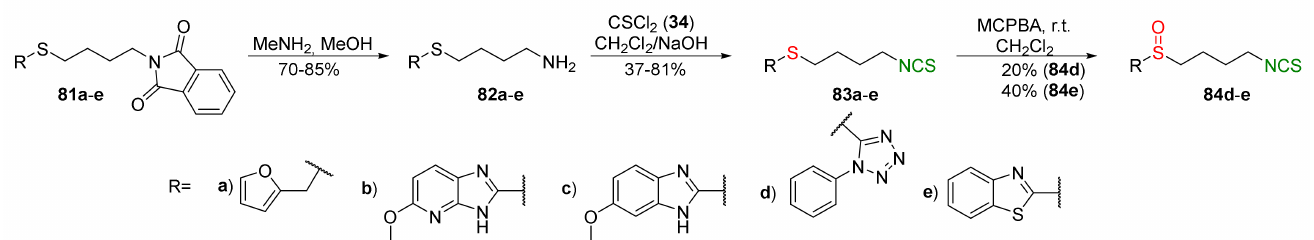
Figure 22. Synthesis of heterocyclic analogues 84d – e of SFN. Sulfoxide and sulfone analogues of SFN with heterocyclic moieties 84a – c and 89a – c